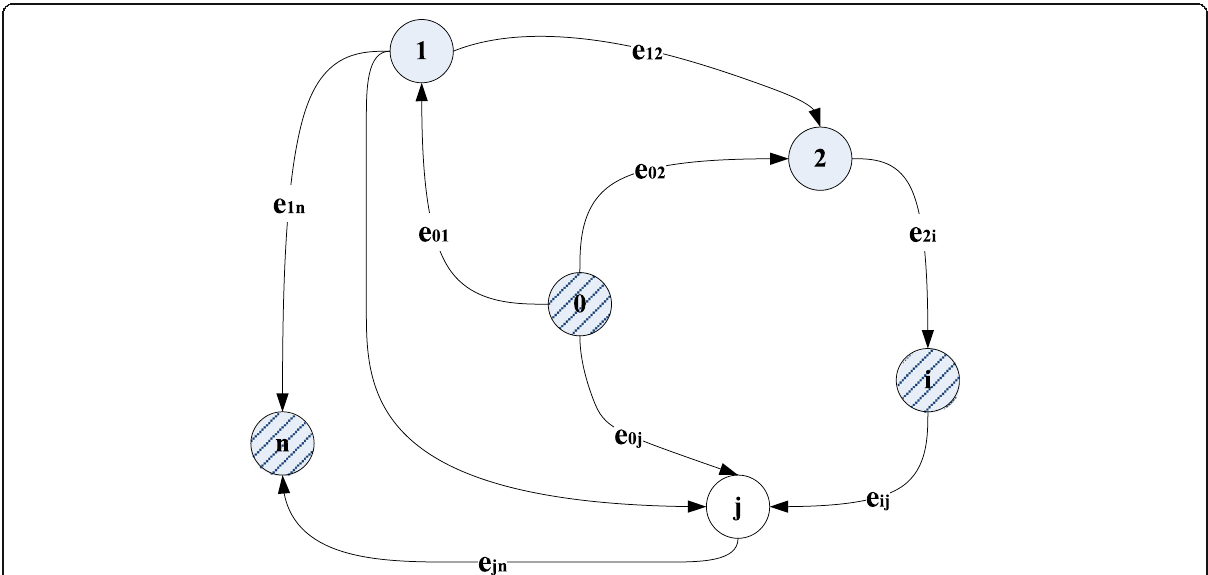
Fig. 4 Fine-grained directed acyclic graph task topology model. It is a topological model of a fine-grained directed acyclic graph task topology. A directed acyclic graph (DAG) is used to represent the complex dependencies among subtasks. For the graph G , G = ( V , E ), the node set V represents the task set to be processed, v ∈ V represents the divided subtask, E represents the directed edge set, represents the dependencies between the tasks, and e uv ∈ E represents the amount of transfer data between the task u and the task v , which represents when the task u is finished, e uv data is transmitted to task v , task v can start execution only after task u is executed